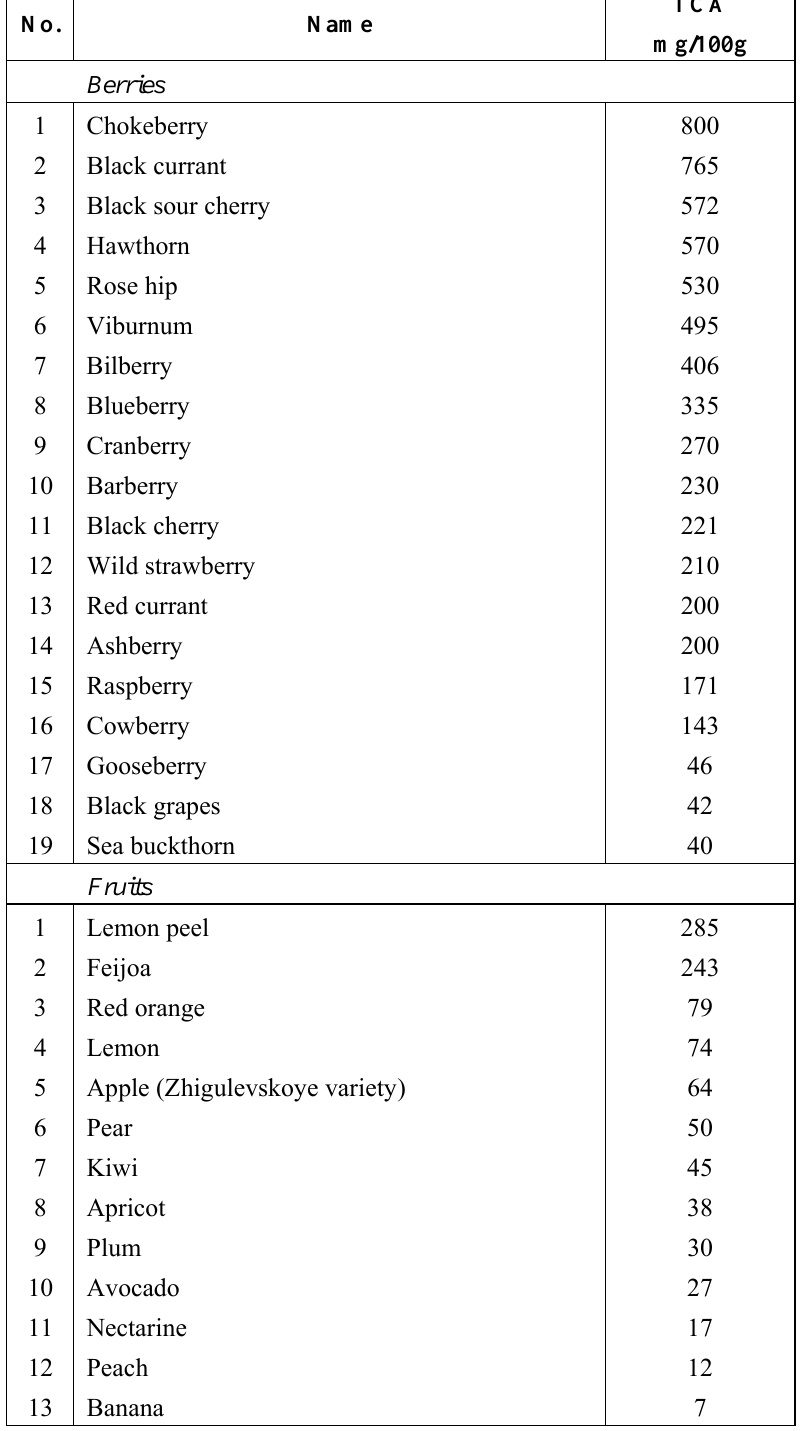
Table 1. Total Content of Antioxidants (TCA) in Berries and Fruits (quercetin – standard).